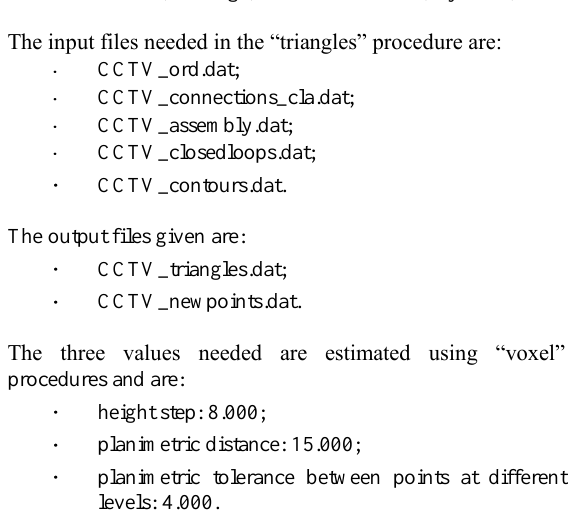
Figure 22. Classic perimeter for the contour of a sown (level 235.000)